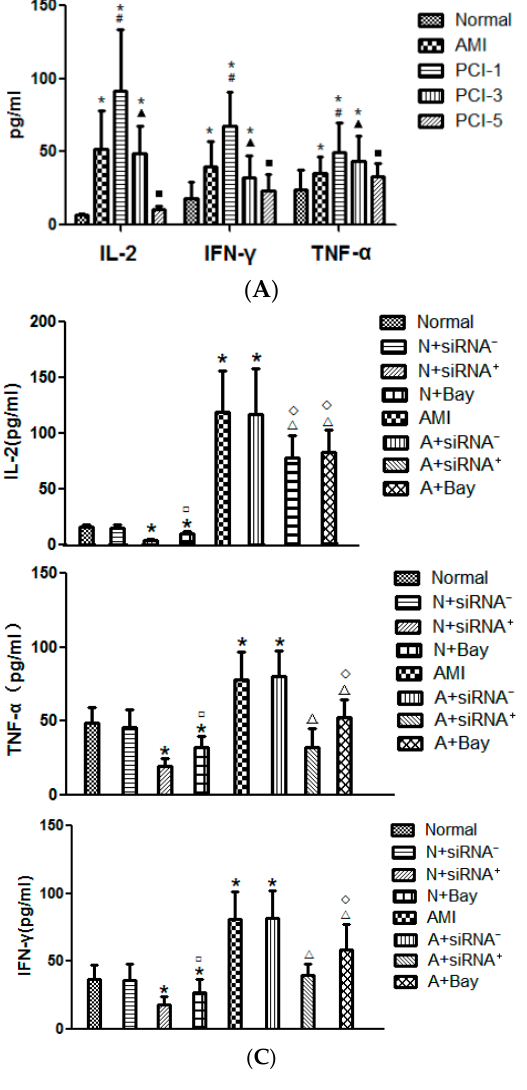
Figure 5. The levels of cytokines in the different stages of AMI and PCI and changed by CaSR siRNA transfection and NF- κ B pathway blocker ( n = 20). The levels of Th-1 type and Th-2 type cytokines in the plasma and the supernatant of cultured T cells were detected by Cytometric Bead Array. ( A , B ) Showed that the plasma levels of cytokines in AMI onset and at the different stages of PCI; ( C , D ) show the Th-1 and Th-2 type cytokines concentration after T lymphocytes were transfected by CaSR siRNA plasmid for 24 h or cultured by NF- κ B pathway blocker Bay-11-7082 (10 mM) for 15 min in the supernatant. * p < 0.05 vs. Normal; # p < 0.05 vs. AMI group; ▲ p < 0.05 vs. PCI-1 group; ■ p < 0.05 vs. PCI-3 group; □ p < 0.05 vs. Normal + siRNA + ; Δ p < 0.05 vs. AMI; ◊ p < 0.05 vs. AMI + siRNA + .